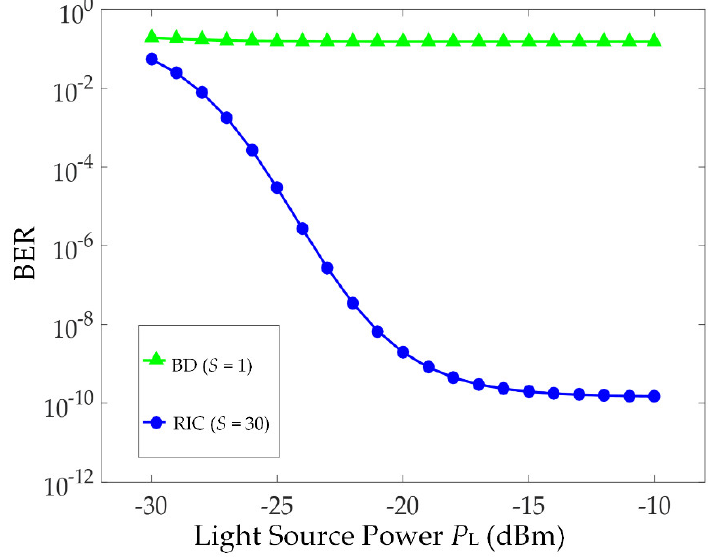
Figure 10. Bit-error rate (BER) versus the light source power.